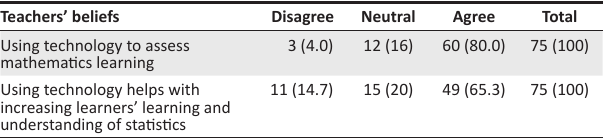
TABLE 7: Teachers’ beliefs about using technology in teaching and